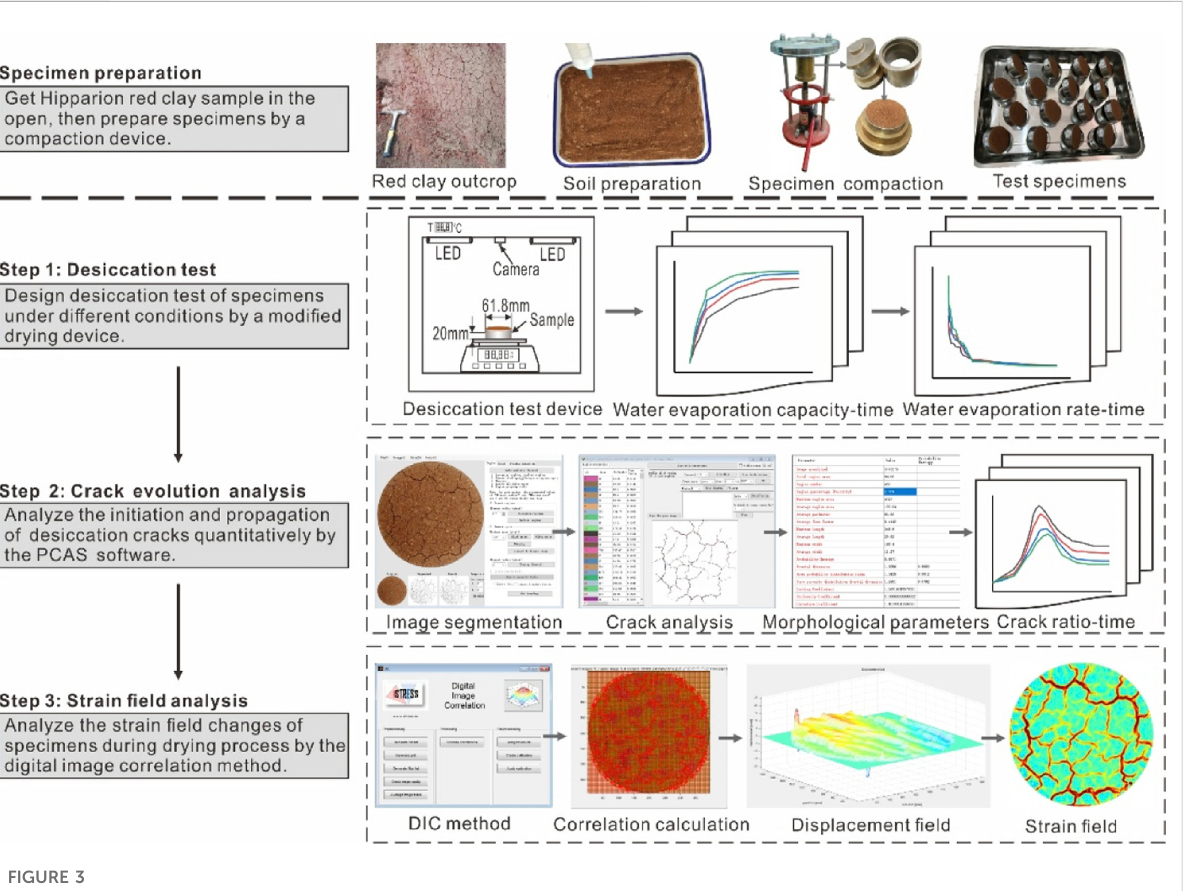
FIGURE 3 Test methods and